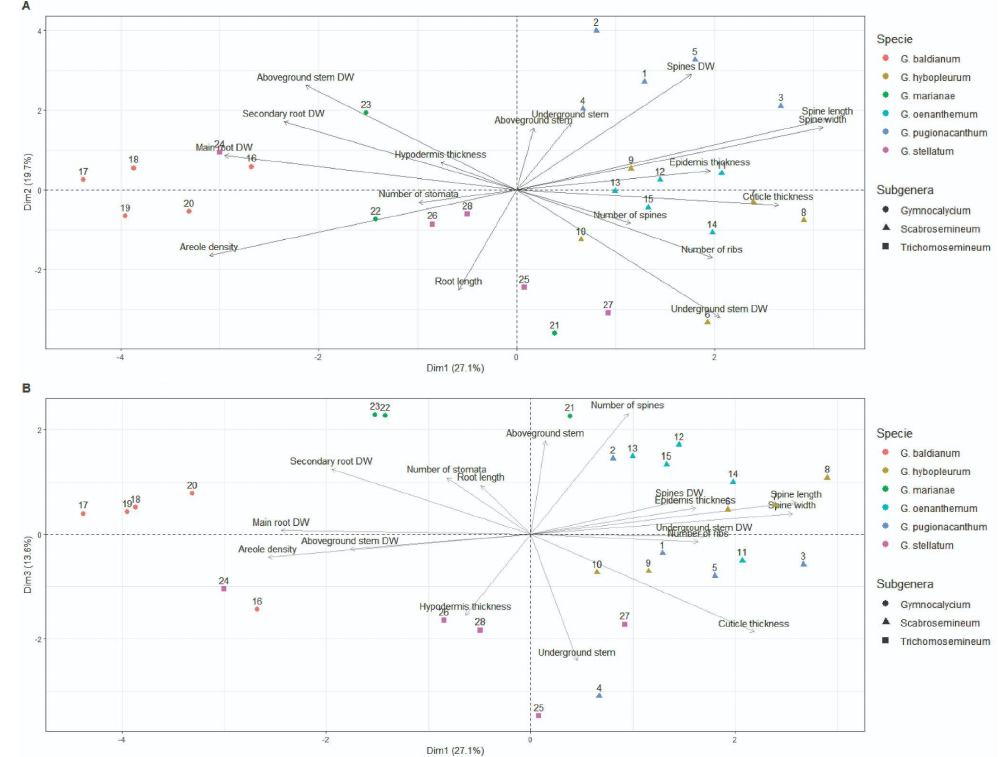
Figure 5. PCA biplots. ( A ): Representation of the first principal component (Dim 1) and the second one (Dim 2). ( B ): Representation of first and third principal components (Dim 3). The subgenera are represented with different shapes and the species with different colors. Table 2. Eigenvalues, percentage of variance explained by each principal component, and cumula- tive percentage of variance. Notice that the first three components were considered, since they were the components that explained most of the variability .